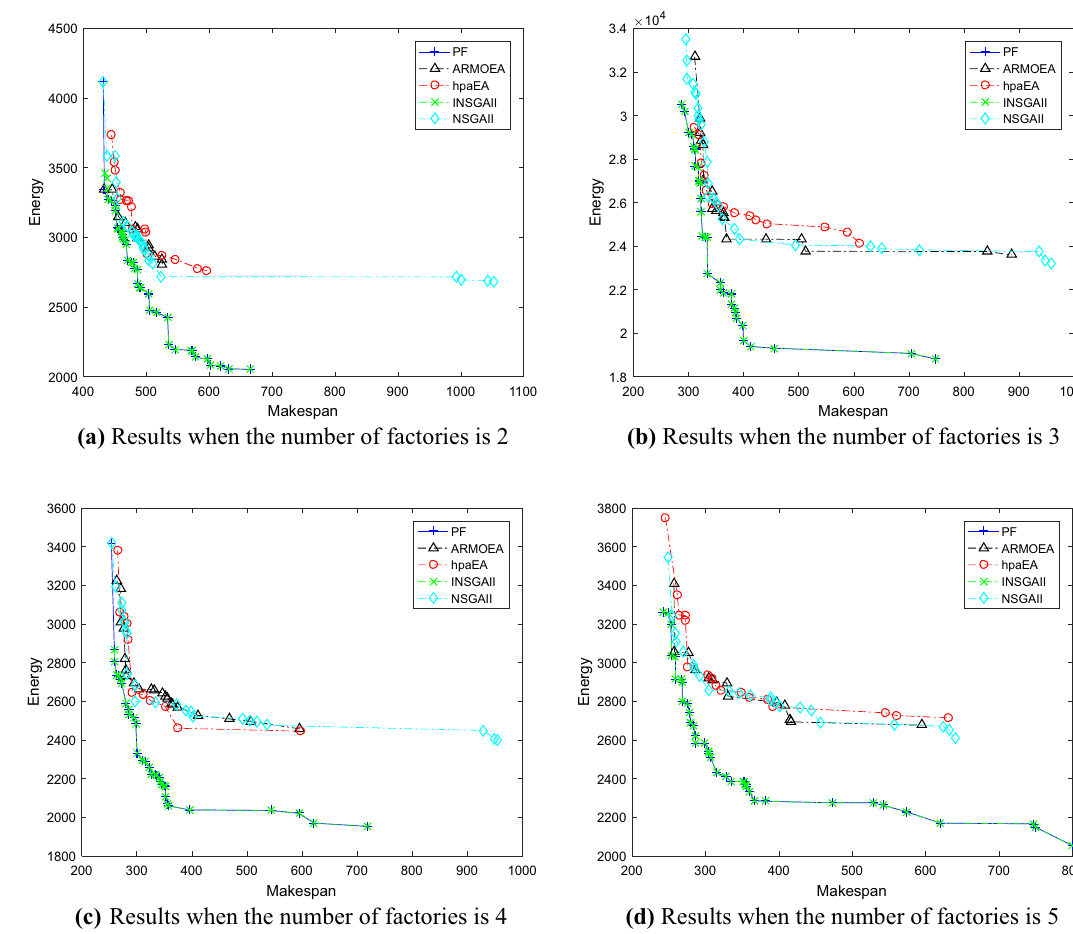
Fig. 11 Pareto front of the compared algorithms